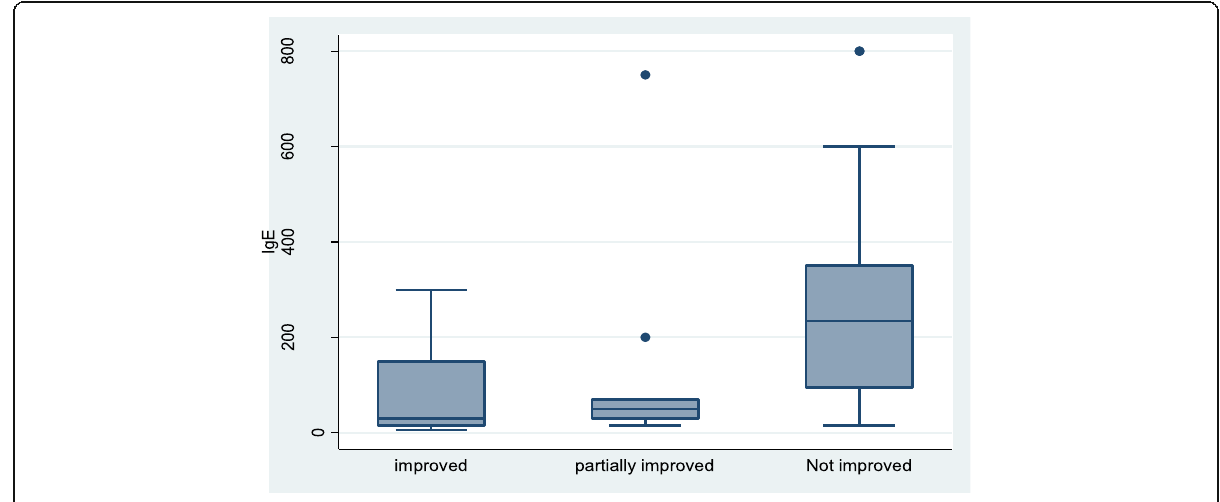
Fig. 1 IgE level among studied patient according to patients ’ improvement